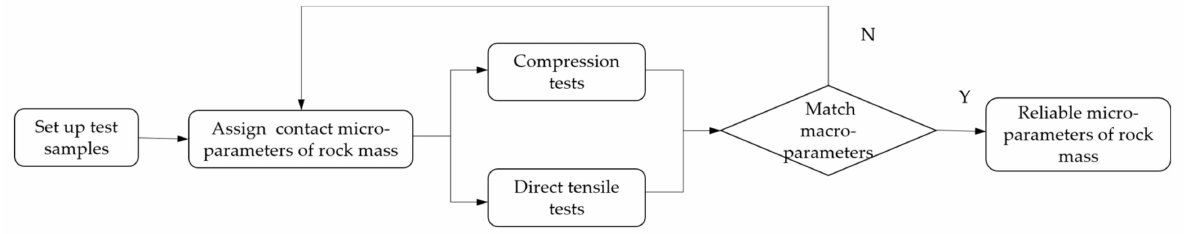
Figure 7. Flowchart summarizing the method of calibrating microparameters.